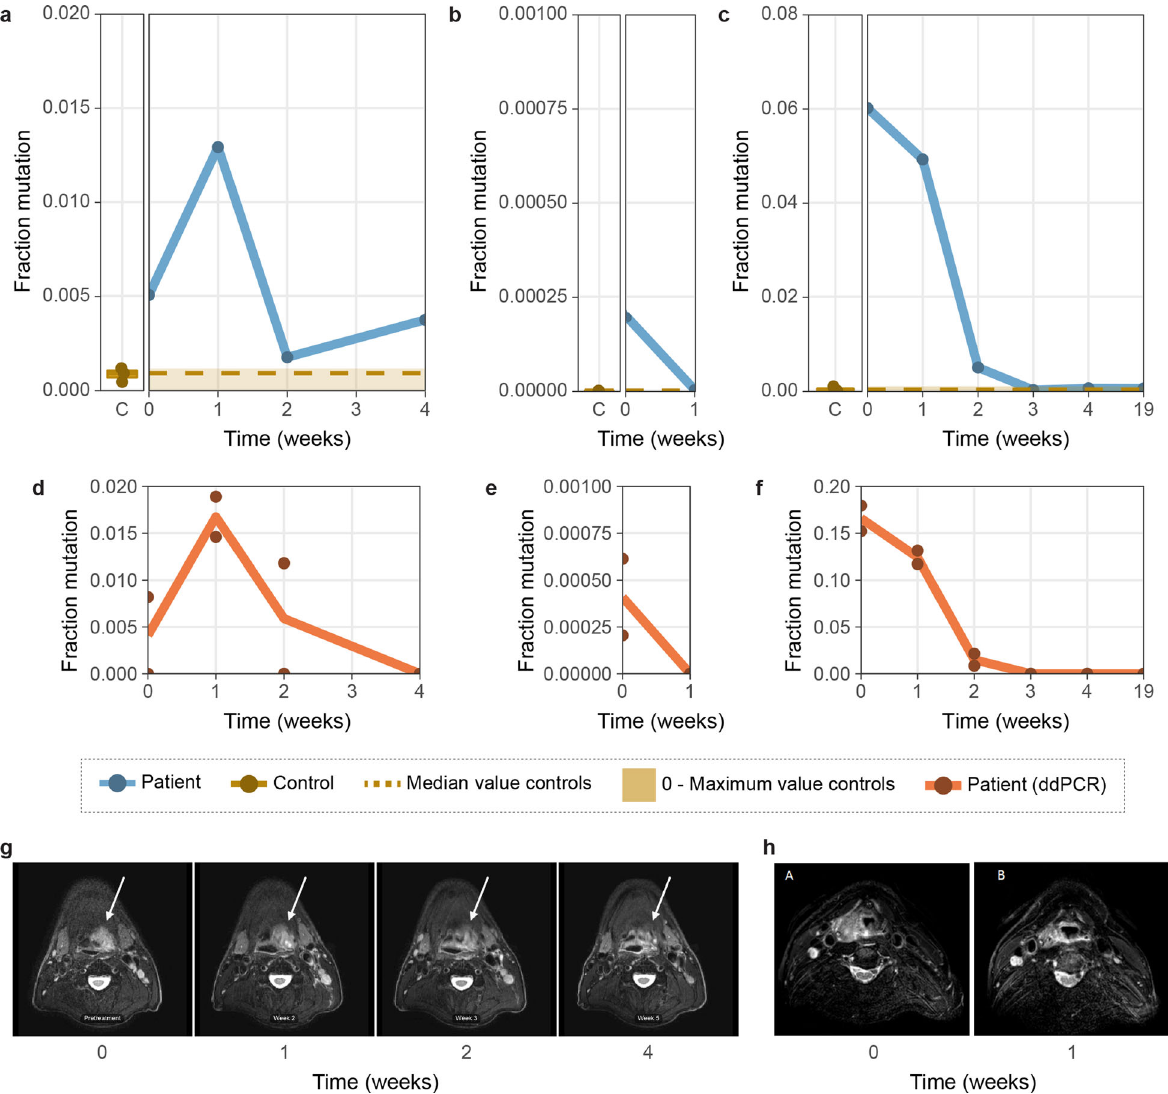
Fig. 6 Mutated ctDNA in the blood of patients and controls. a 17:7577121 G > A in Patient A (right panel of fi gure a ) and three controls (left panel of fi gure a ). b 17:7577095 – 7577123 deletion in Patient B (right panel of fi gure b ) and two controls (left panel of fi gure b ). c 17:7578403 C > T in Patient C (right panel of fi gure c ) and fi ve controls (left panel of fi gure c ). d 17:7577121 G > A in Patient A in ddPCR. e 17:7576870 C > A in Patient B in ddPCR f 17:7578403 C > T in Patient C in ddPCR. g MRIs of patient A. White arrow indicates the primary tumor. h MRIs of patient B. Each data point is a single measurement and lines show the mean measurement per time in weeks. C indicates ‘ controls ’ . Time indicates the time in weeks after treatment initiation. Median and 0-Maximum values in controls are depicted in yellow in the patient panels of CyclomicsSeq, to support a clear comparison between patients and